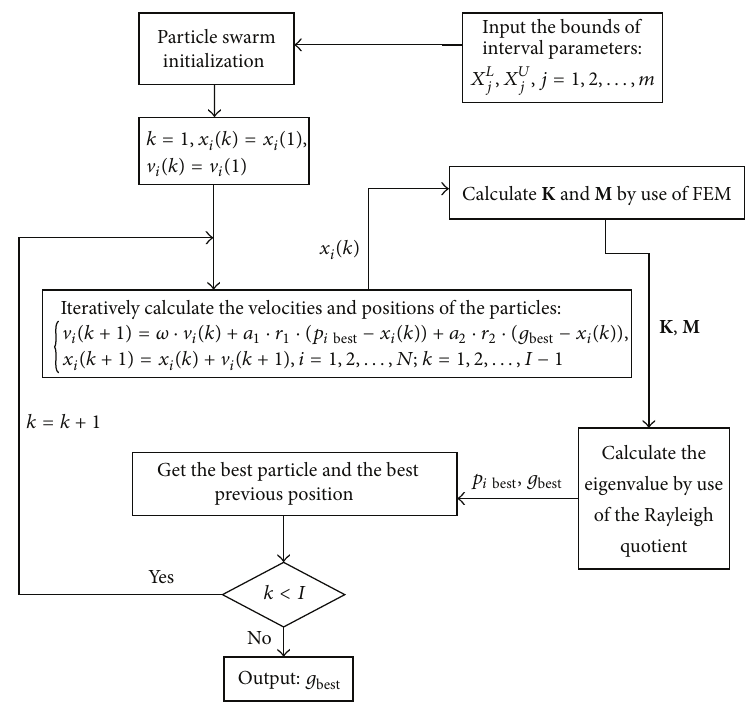
Figure 5: Flowchart of the PSO procedure to calculate ranges of the natural frequencies.